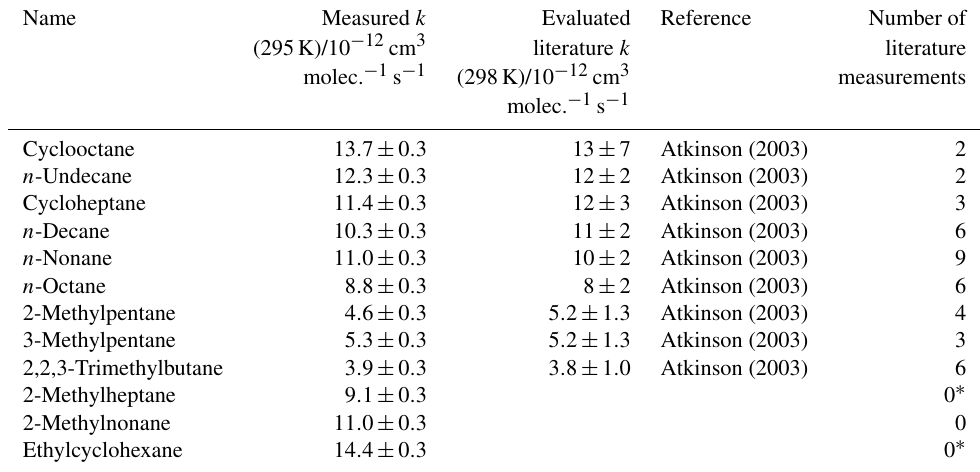
Table 4. Results of relative rate experiments, with evaluated literature data, for each VOC in Mixture 4, ordered by evaluated literature k value.